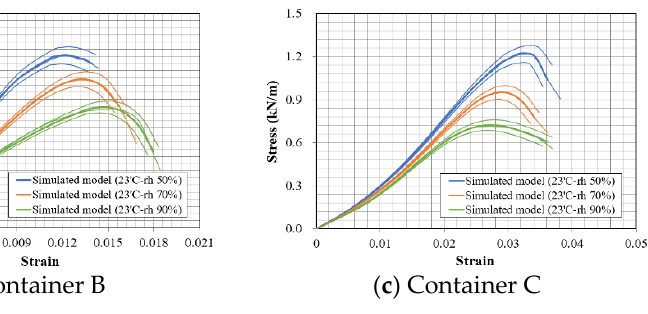
Figure 3. Stress–strain curves for the target shipping containers. Table 4. Compressive properties of the target shipping container according to the equilibrium con- dition [14].